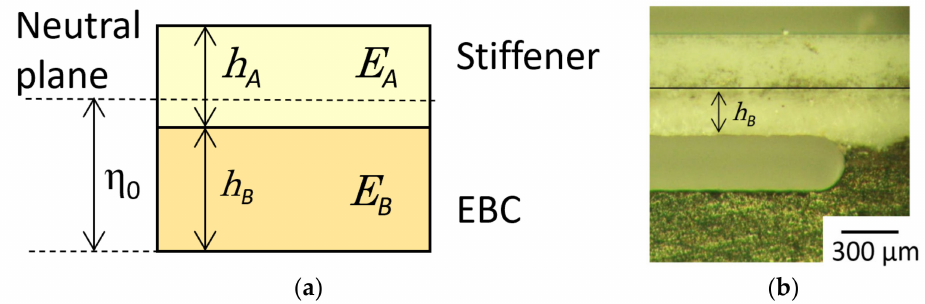
Figure 8. Additional information for the determination of the equivalent bending stiffness in a sketch ( a ) and a cross section ( b ).